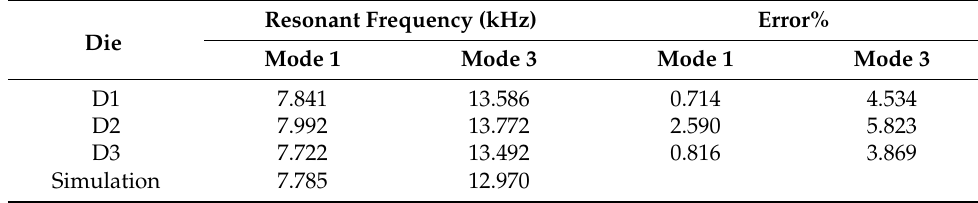
Table 2. Measured resonant frequency modes of the